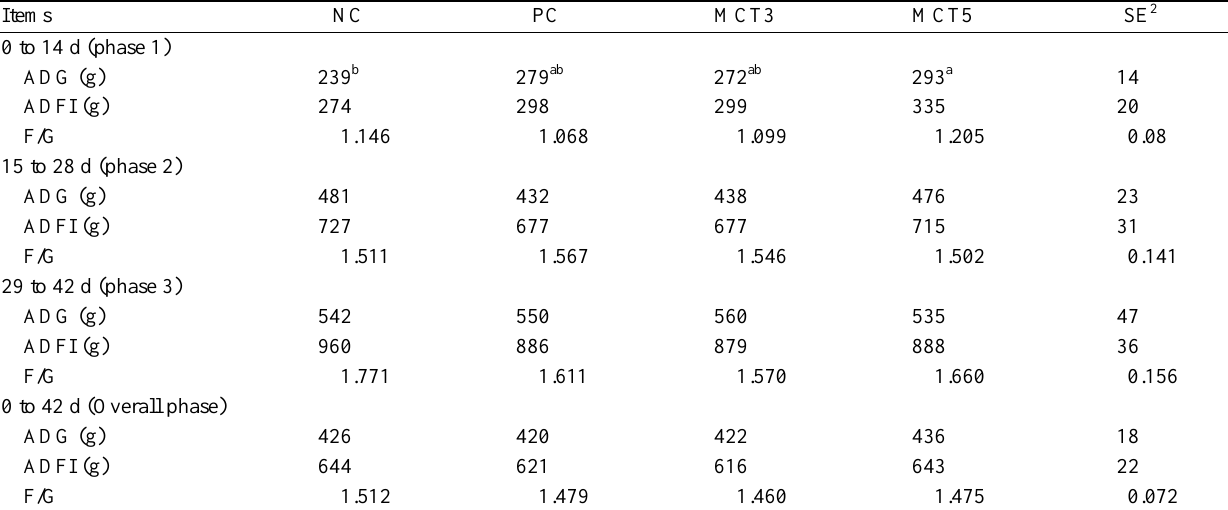
a,b Within a row, mean with different superscripts differ (p<0.05). 1 Each mean represents 6 pens with 5 pigs each per treatment. Dietary treatments were as follows: NC = Negative control diet; PC = Positive control diet with 40 mg/kg Tiamulin, 110 ppm Tylosin, and 10 mg/kg Enramycin. MCT3 = NC+0.32% medium-chain-triglyceride. MCT5 = NC+0.55% (phase